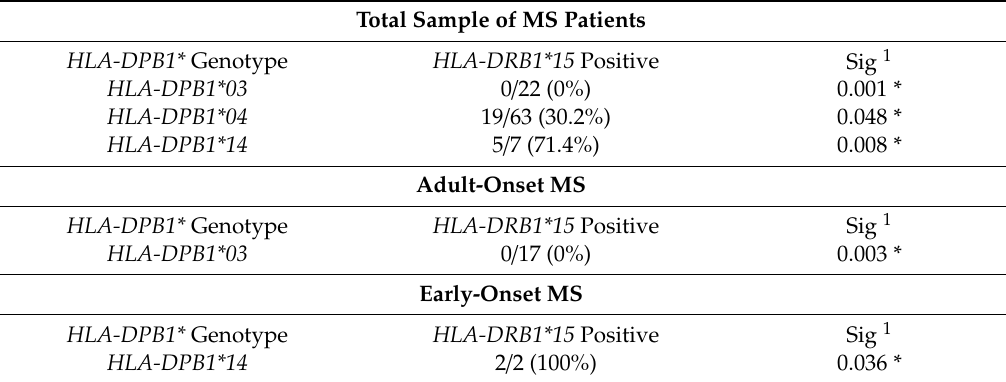
Table 3. Significant DRB1*15 Positivity Di ff erences among HLA-DPB1 Alleles and Age of Onset Groups in Multiple Sclerosis (MS)